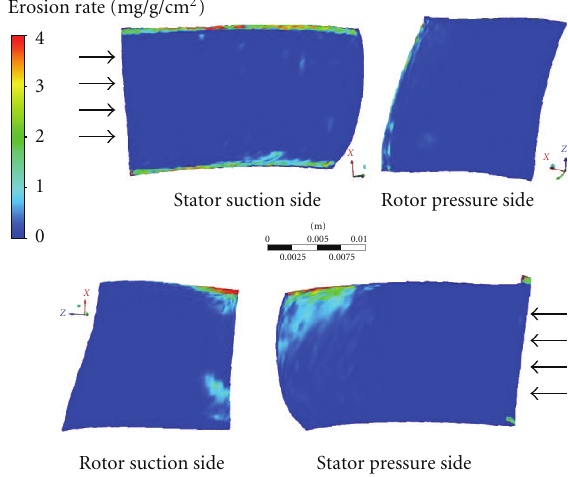
Figure 13: TBC erosion rates on blade surfaces in the commercial turbine for particles seeding within 5% of stator blade span near the hub and shroud at 50% of the gas